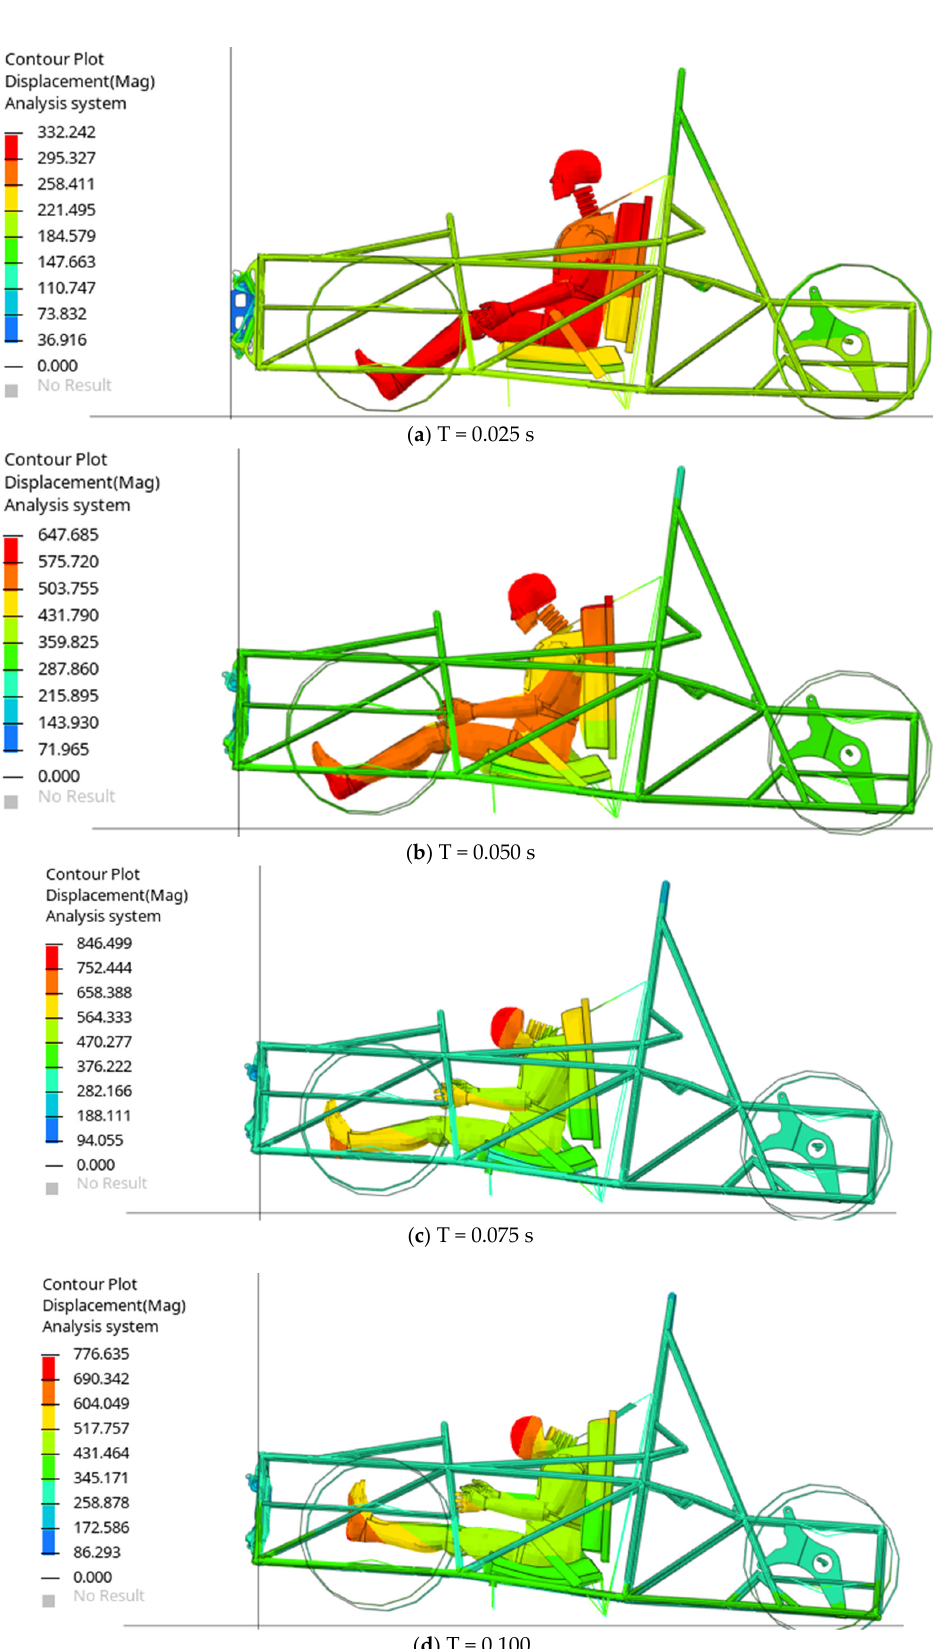
Figure 7. Position after: ( a ) T = 0.025 s; ( b ) T = 0.050 s; ( c ) T = 0.075 s; ( d ) T = 0.10 s. The dimensions are in mm.